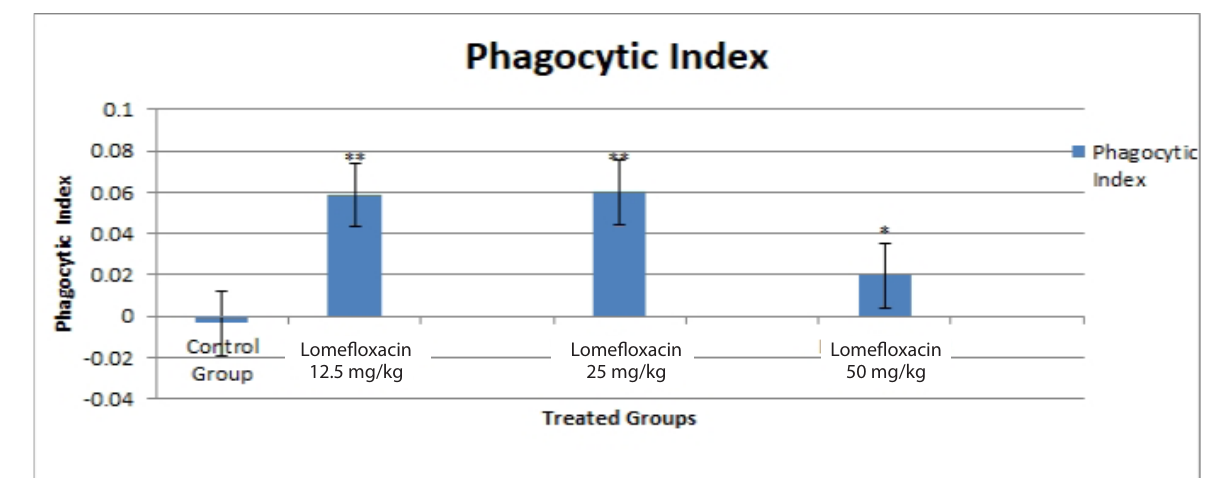
FIGURE 3 - Phagocytic index of treatment groups.